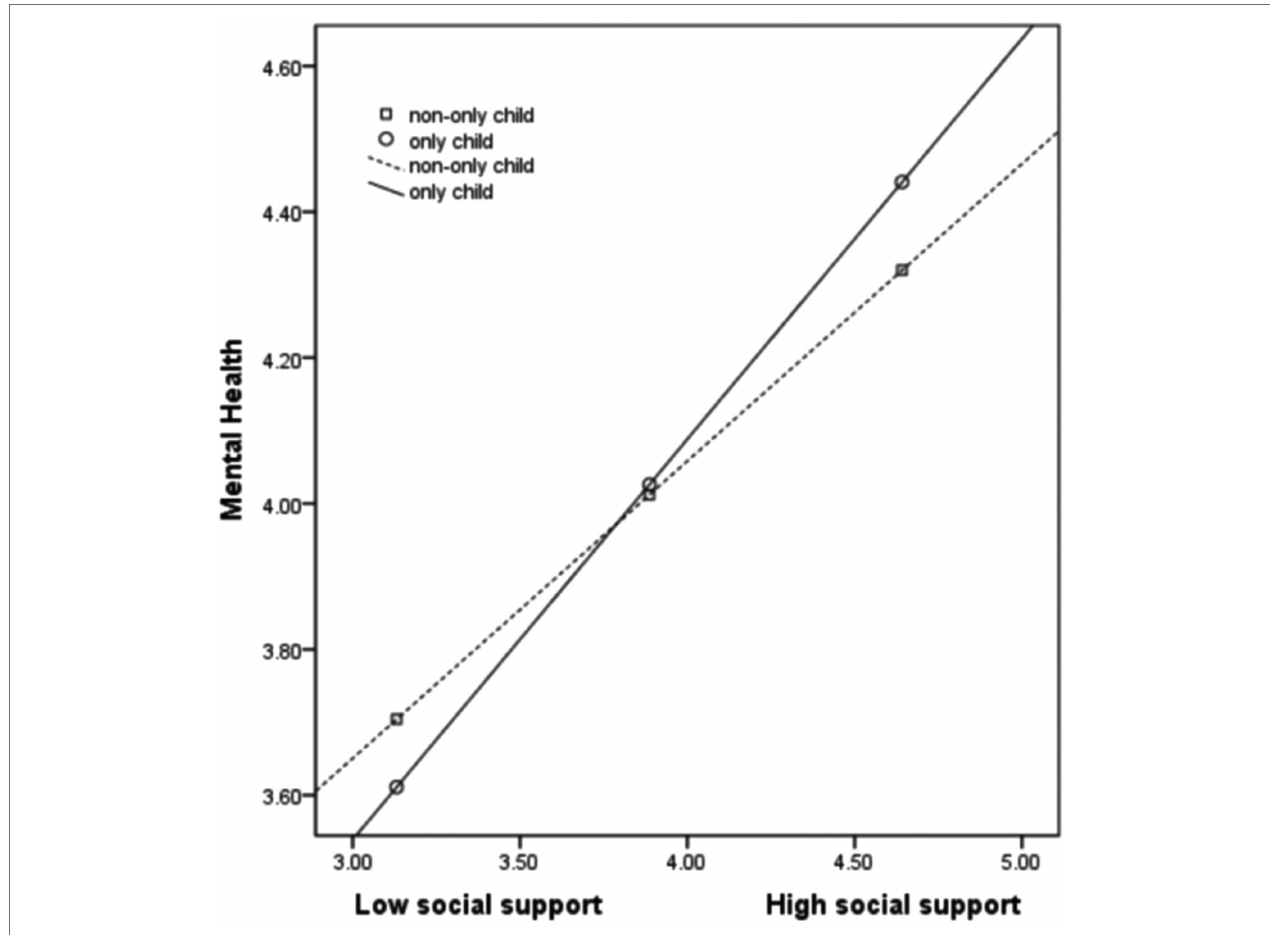
FIGURE 2 | Moderating effect of only-child/non-only-child status on the relationship between social support and mental